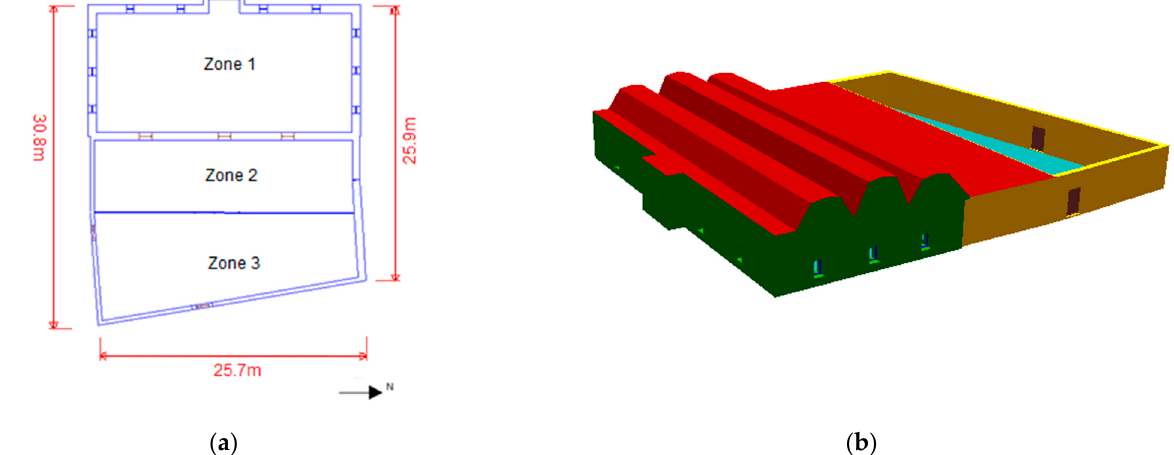
Figure 7. ( a ) Al Wafi Mosque floor plan showing zones in Tas (Reproduced from [22]); ( b ) 3D view of Al Wafi Mosque.